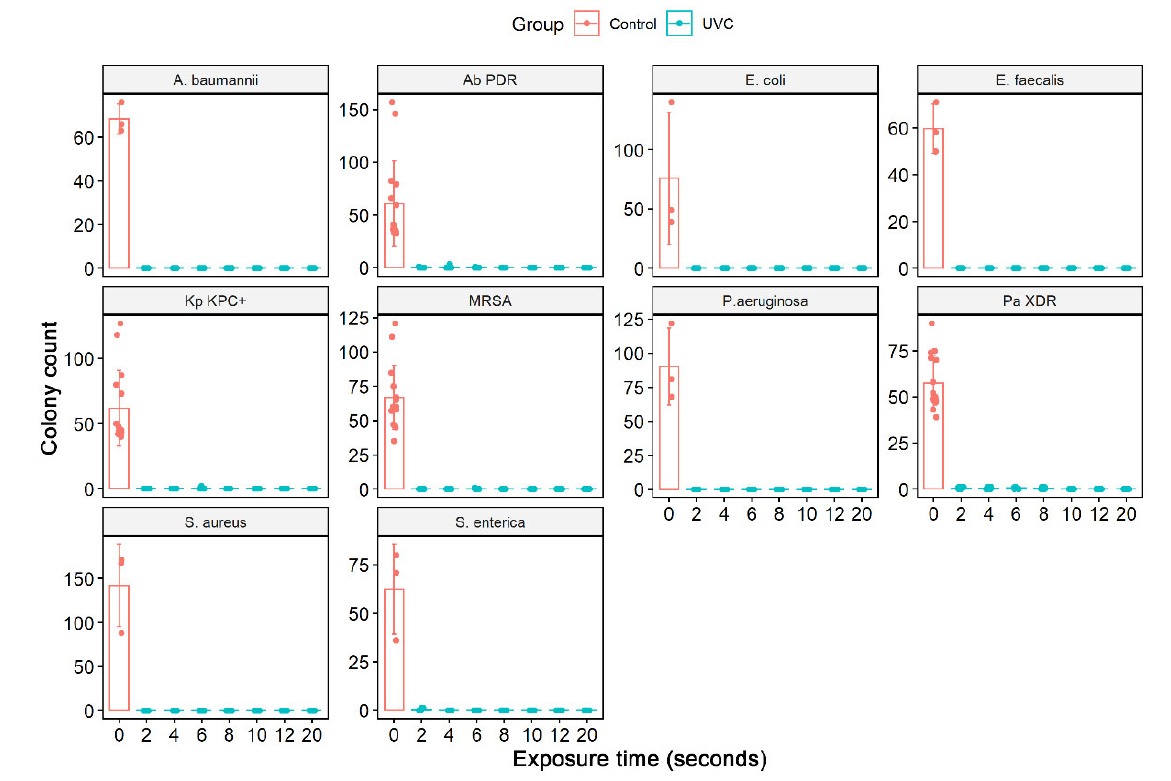
Figure 4. Quantifying the number of CFU/mL in the solid medium of the different bacterial strains ATCCs ( S. aureus (ATCC 6538), P. aeruginosa (ATCC 15442), S. enterica (ATCC 10708), E. coli (ATCC 25922), A baumannii (ATCC 19606), and E. faecalis (ATCC 29212) and MDR strains representative of the ESKAPE ‐ E group S. aureus (MRSA), P. aeruginosa (XDR), A. baumannii (PDR) and K. pneumoniae (KPC+)). In addition, the number of CFU/mL was quantified in the bacterial suspensions (10 4 CFU/mL) after exposure to the UV ‐ C system for 2, 4, 6, 8, and 10 s and in the control group (no treatment). Boxes represent median and lines standard deviations. Table 3. Reduction in CFU/mL counts in solid media after exposure to the UV-C system in ATCCs and MDR/ESKAPE-E bacterial strains. The quantification of the number of CFUs was performed in bacterial suspensions of ATCCs strains (10 4 CFU/mL) and MDR strains representative of the ESKAPE-E group (10 4 CFU/mL) after exposure to the UV-C for 2, 4, 6, 8, and 10 s and control group (no